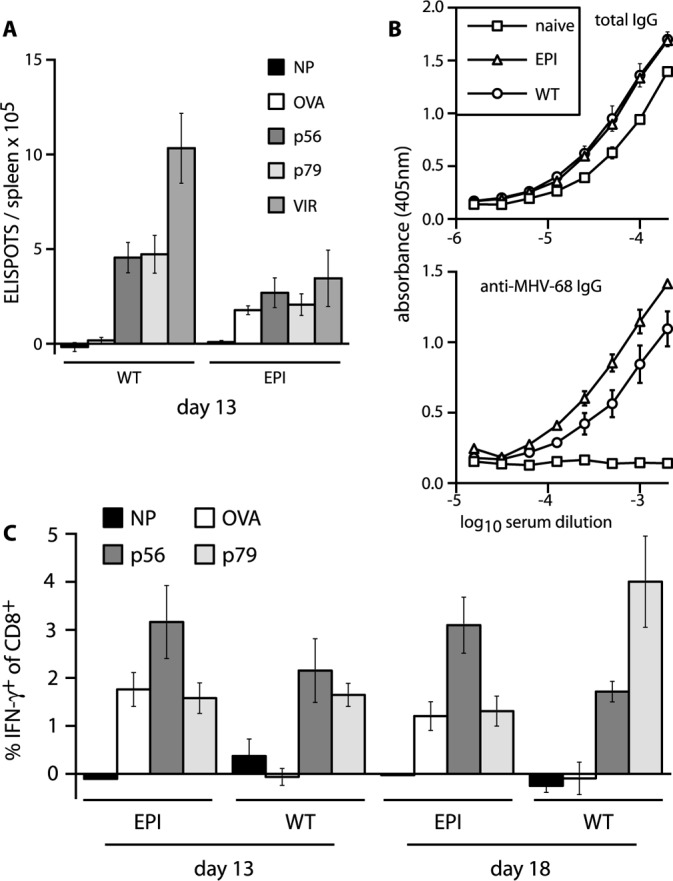
Antigen-Specific Immune Responses to the IRES-EPI Virus(A) CD8+ and CD4+ T cell responses were measured by interferon-gamma ELISPOT assay 13 d post-infection. The response to virus-exposed targets (VIR) is mediated by CD4+ T cells; the response to the p56, p79, and SIINFEKL (OVA) peptides is mediated by CD8+ T cells [62]. The mean number of spots with untreated targets was subtracted from the number of spots with each specific target. There was a response to the OVA peptide in the IRES-epitope construct, but not to the ASNENMETM peptide (NP). Mean ± SD values of five mice per group are shown.(B) Total and MHV-68 virion-specific serum IgG responses were measured by ELISA at 18 d post-infection. “Naive” indicates age-matched, uninfected controls. Mean ± SD absorbance values of four mouse sera per group are shown.(C) Spleen cells were stimulated for 5 h in the presence of Brefeldin A plus the peptide indicated and then stained for cell-surface CD8 and intracellular interferon-gamma. The percentage of interferon-gamma+ CD8+ cells without peptide was subtracted from the value with peptide to give the specific response. Mean ± SD values of five mice per group are shown.